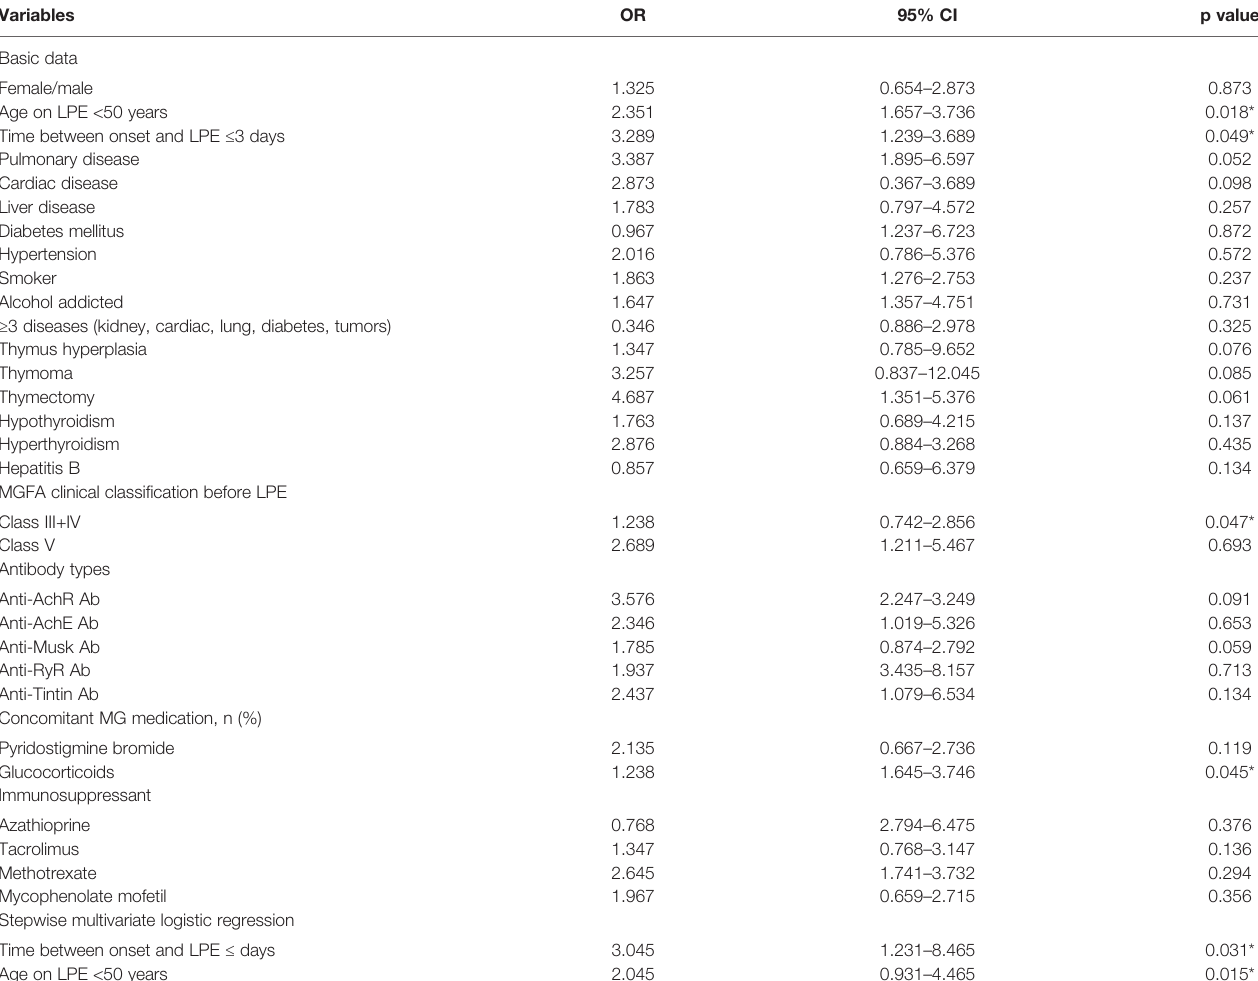
TABLE 2 | Predictive factors affecting the outcome of LPE therapy on groups with QMG score improvement more than 50 percentage.